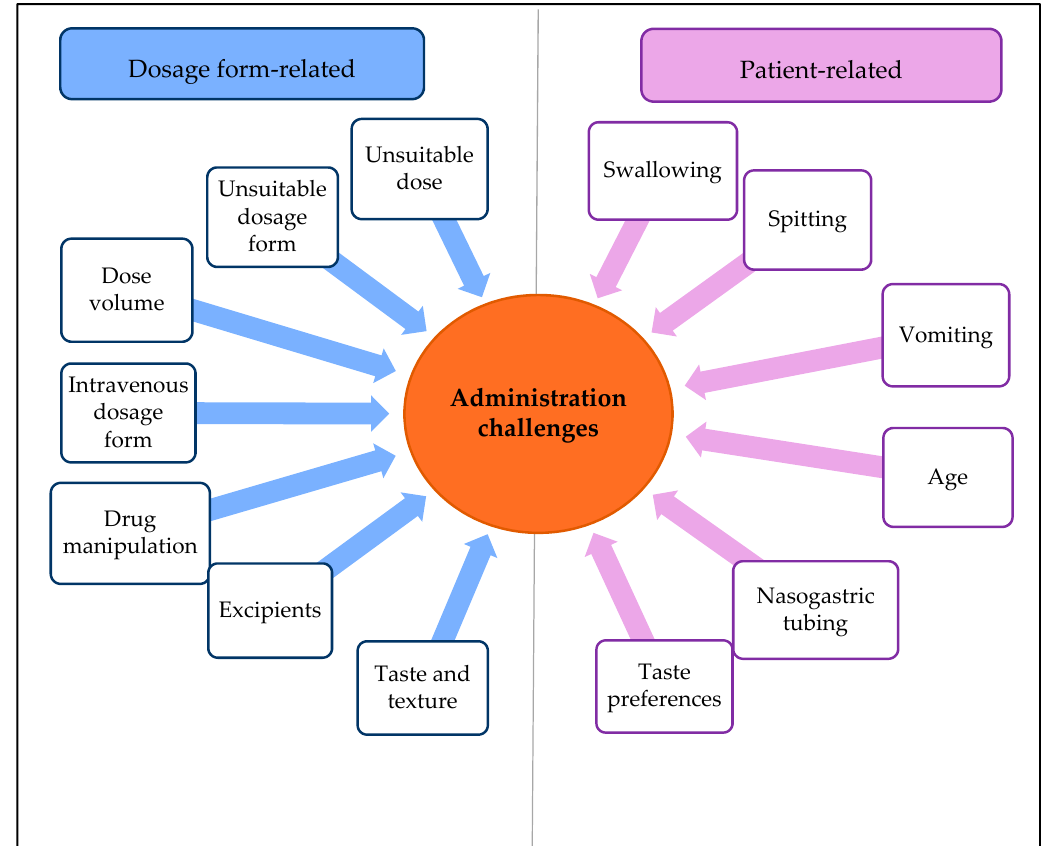
Figure 2. Identified administration challenges of oral medication at pediatric hospital wards divided into dosage form and patient-related challenges.